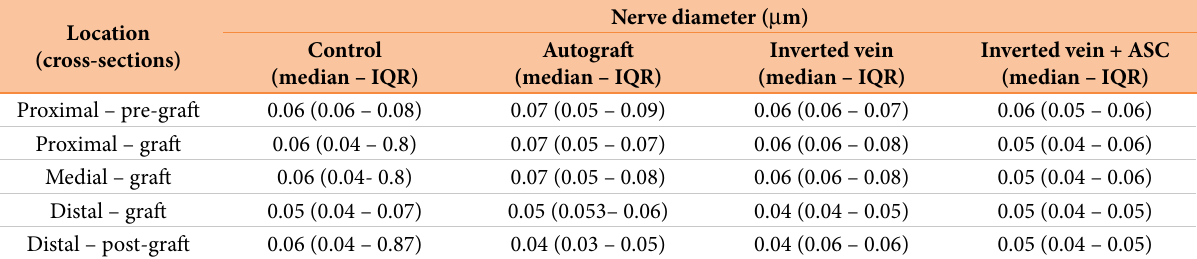
Table 4 - Diameter of nerve bundles after 12 weeks of prospective neural regeneration. Histological measurements of slides were performed at five locations (cross-sections) of the right sciatic nerve: proximal pre-graft or neurorrhaphy, proximal – graft, medial – graft, distal – graft, distal – post-graft diameter values in μ m are described as median –